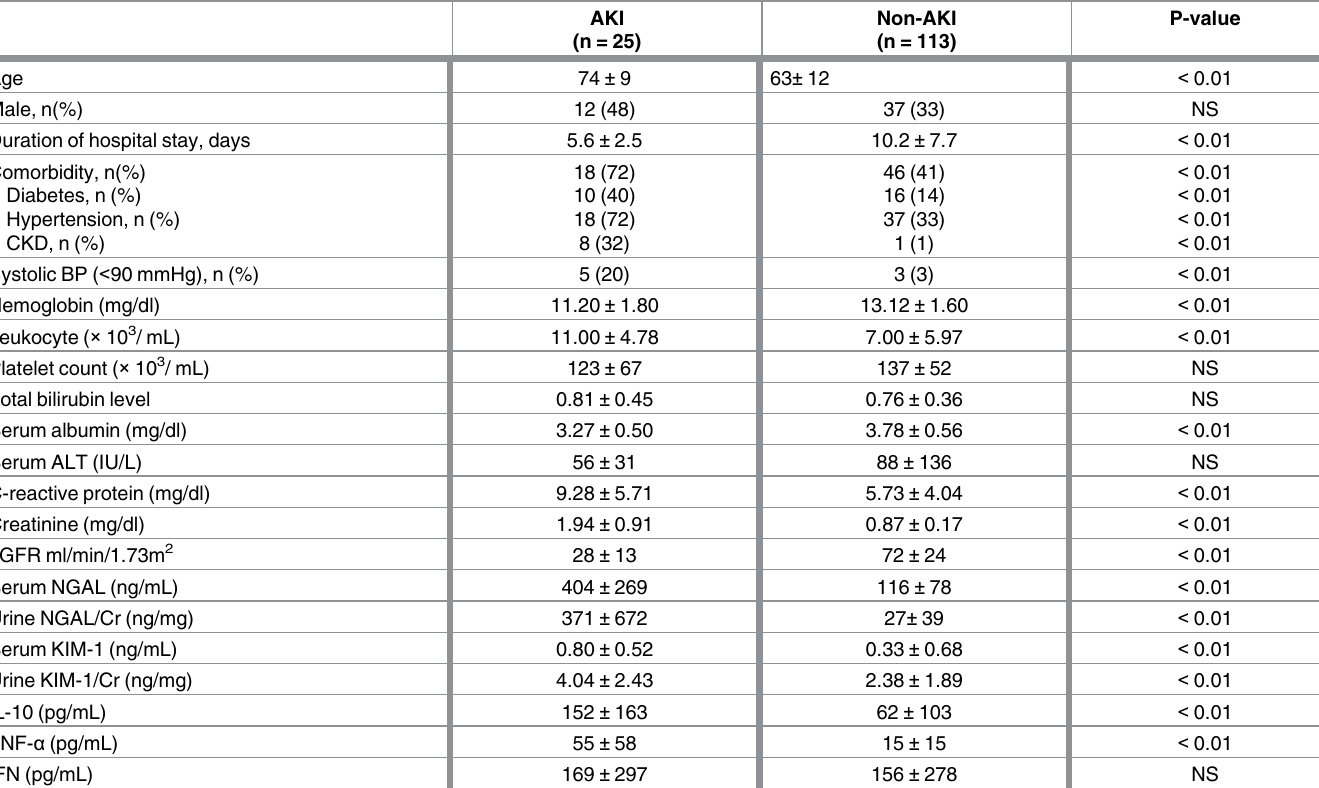
Table 2. Comparison of baseline characteristics between non-AKI and AKI group.